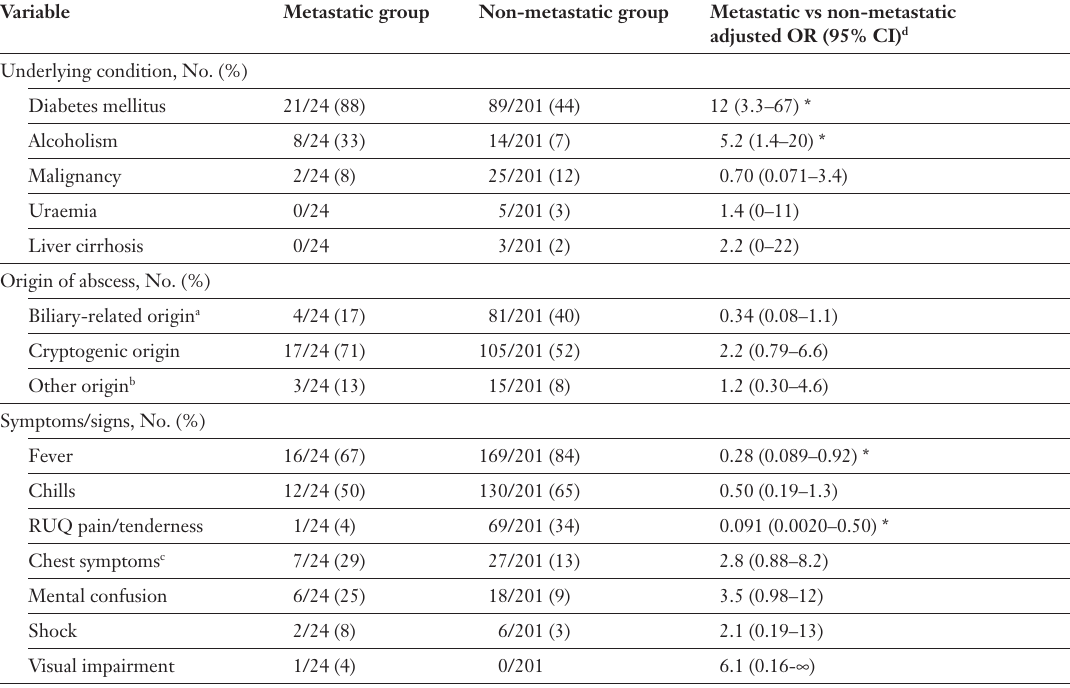
Table 2 Underlying diseases, origin of abscess, and clinical features at admission in the metastatic and non- metastatic infection